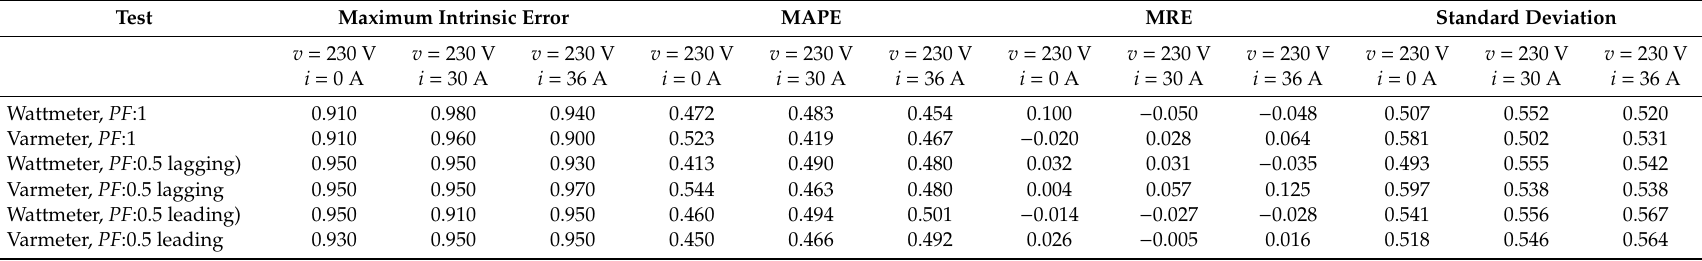
Table 12. PF variation test (wattmeter and varmeter, current variation): maximum intrinsic error (%), MAPE (%), MRE (%), and standard deviation